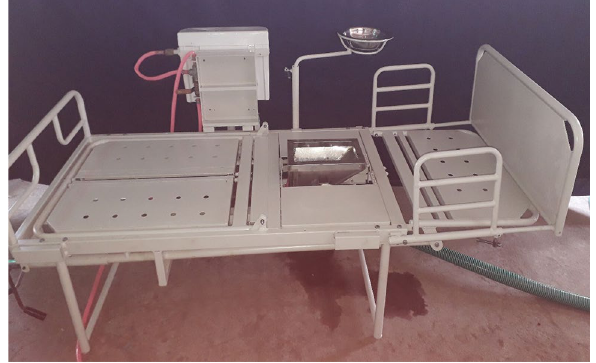
Fig. 3 New bed with side tilting arrangement